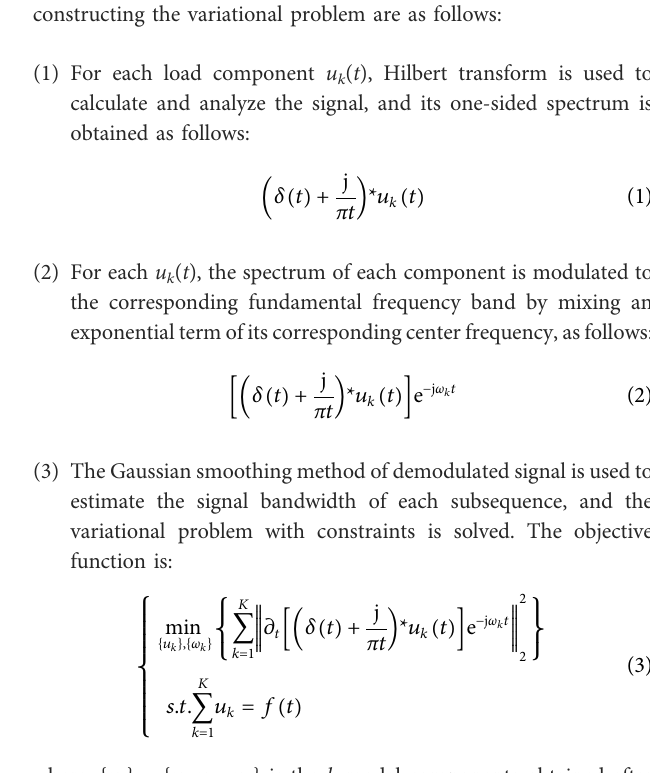
FIGURE 1 Flow chart of